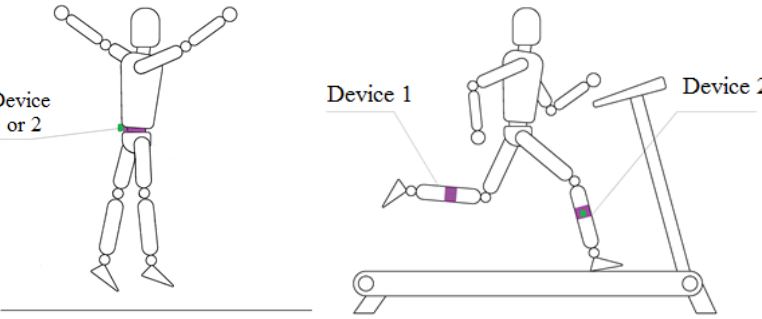
Figure 1. Devices placement on shanks and pelvis during running and jumping tasks.